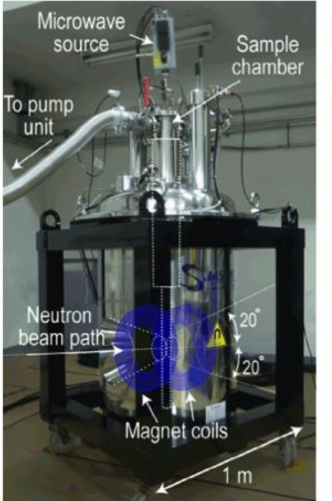
Figure 17. Superconducting magnet for dynamic nuclear polarization (DNP) on